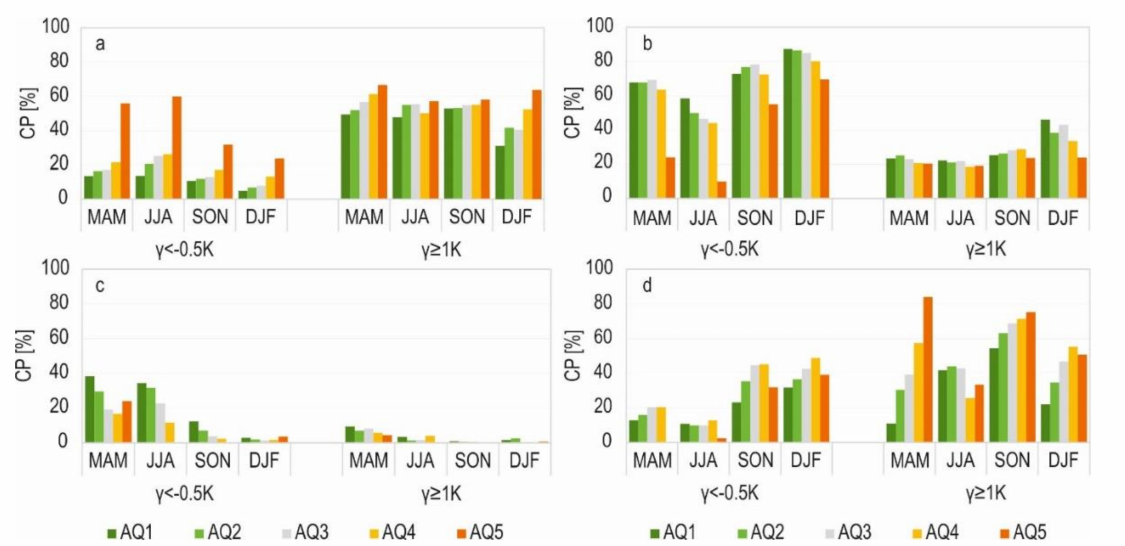
Figure 11. Conditional probability (CP) of clear ( a ), cloudy ( b ), dry ( c ) and wet ( d ) hours conditioned by air stability (strong and conditionally unstable conditions: γ < − 0.5 K, stable conditions: γ ≥ 1.0 K) and air quality (AQ) in GZM. CP calculated as a quotient of the number of particular days (e.g., clear days) and the number of days with particular AQ and air stability (e.g., AQ5 and γ ≥ 1.0 K) and expressed in